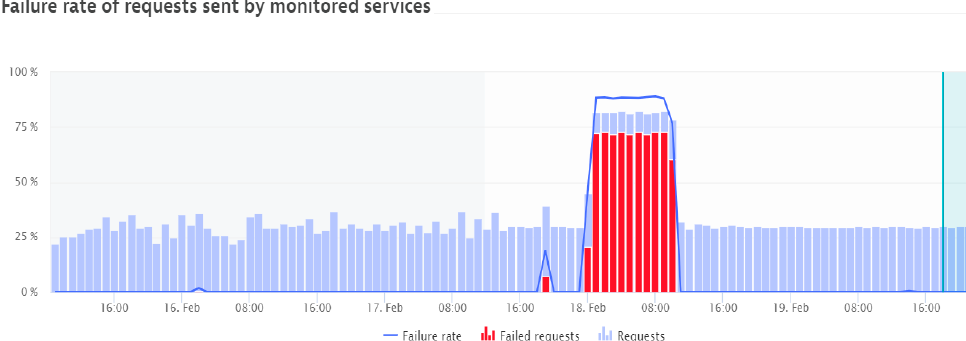
Figure 7. Failure rate of requests in a service breakdown period.